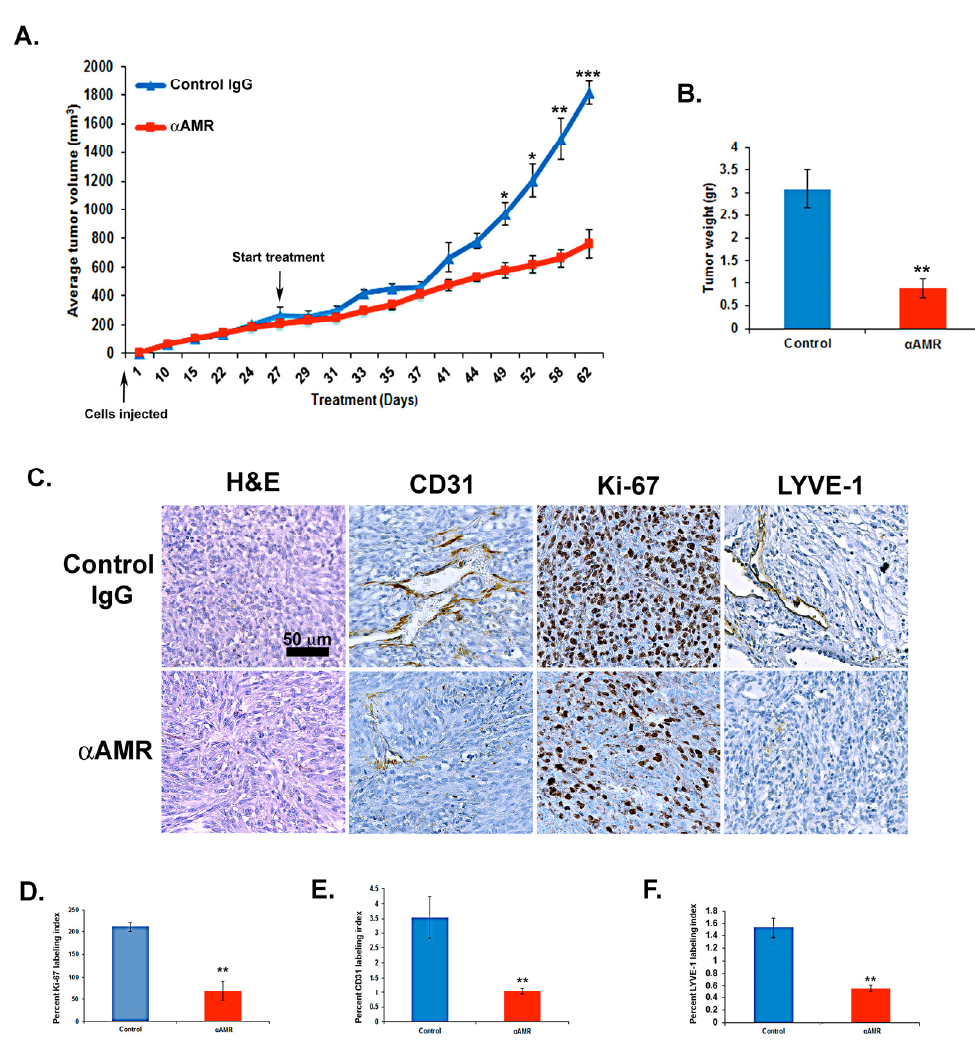
Figure 7. AM signaling blockade inhibited the growth of MeWo xenografts in vivo. ( A ) MeWo cells (2 × 10 6 ) were injected subcutaneously into the flanks of athymic nude mice (6 weeks old) (n = 10 in each group). Mice with tumor volumes averaging 250 ± 50 mm 3 received intraperitoneal injections of α AMRs (12 mg/kg) every 3 days. Control mice were treated with 12 mg/kg of nonspecific isotype control immunoglobulin G (IgG). Measurements of tumor volume demonstrate differences in the growth of animals treated with α AMRs (n = 10) and control IgG (n = 10) during the 52-day schedule, * p < 0.05; ** p < 0.01; *** p < 0.001. ( B ) Tumors were weighed immediately after excision and the average tumor is indicated as the mean ± SD (n = 10), ** p < 0.01. ( C ) α AMRs-treated tumors are less vascular and depleted of vascular and lymphatic endothelial cells. LYVE-1, CD31, and Ki-67 antibodies and hematoxylin and eosin were used to stain the tumor sections. The figure depicts Ki-67 positive cells, with each section analyzed using 10 magnification fields (400 × ). Microvessel density was determined using immunohistochemical staining of the CD-31 marker of the endothelial cell surface. The density of cells staining positive for Ki-67 ( D ), CD-31 ( E ), or LYVE-1 ( F ) was assessed quantitatively based on the entire slide surface using CALOPIX Software v2.10.16 by Tribvn. Analysis was conducted with MVF_Image J1.52a software. The values shown represent the means ± SD, ** p < 0.01.